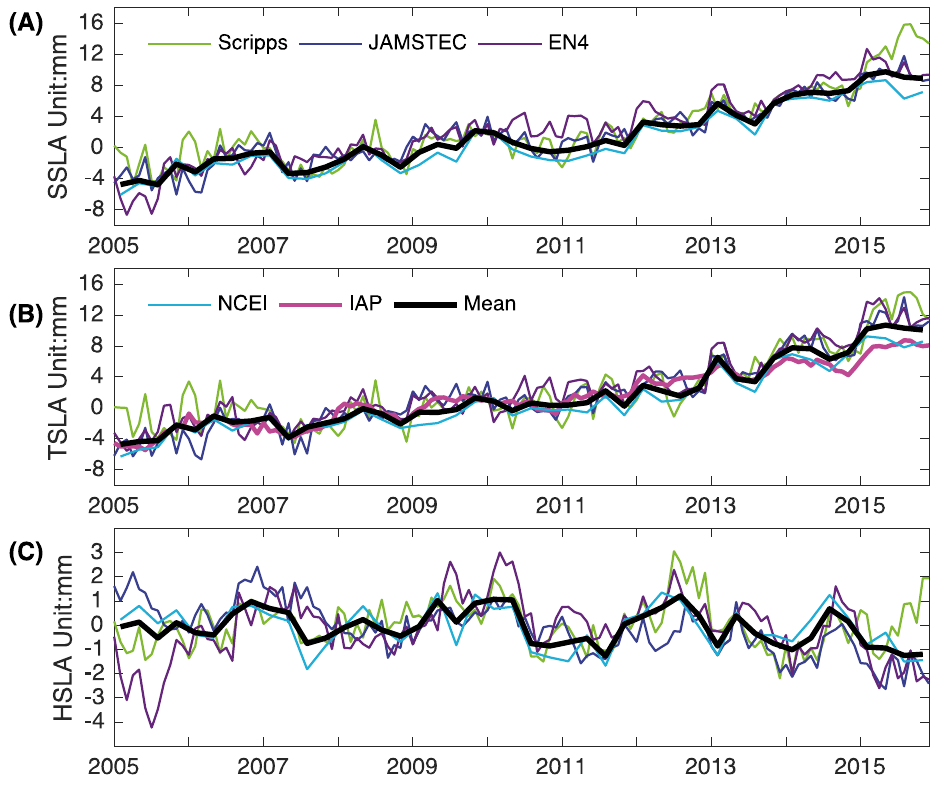
Figure 1. Monthly time series of SSLA ( A ), TSLA ( B ), and HSLA ( C ). Curves show estimates based on products from SCRIPPS, JAMSTEC, EN4, IAP, NCEI, and the mean of the five datasets (black line).